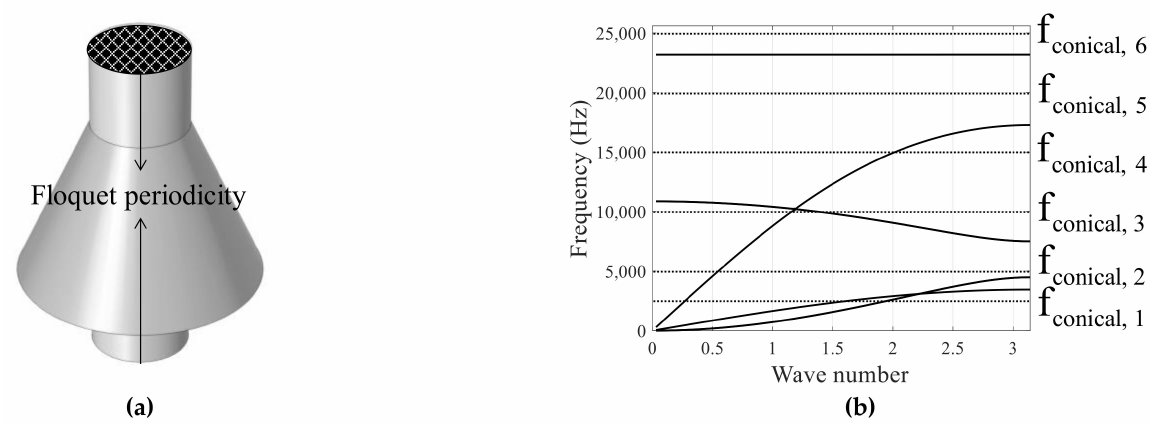
Figure 8. ( a ) Floquet periodic condition of unit cell and ( b ) dispersion relation for a unit cell in conical metamaterials ( r p = 0.03 m, h p = 0.02 m, s = 0.02 m, n = 10).